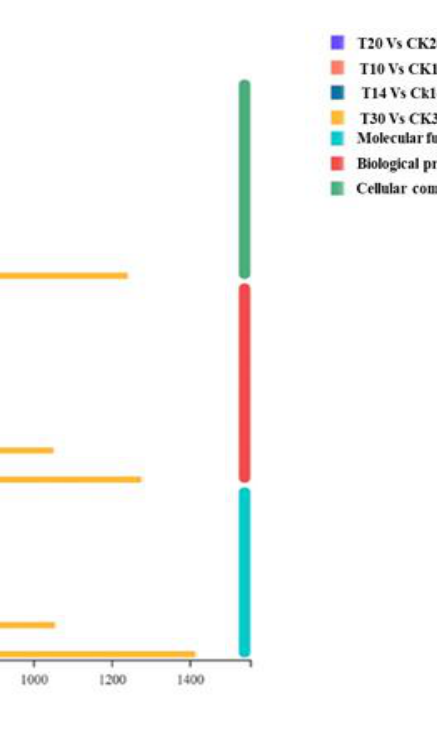
Figure 6. Clusters of KEGG function classification of DEGs based on significantly enriched KEG terms are indicated by dot for corrected p value of <0.05. The dot size represents the number of genes enriched in the reference pathway. There were a total of 108, 115, 99, and 104 DEGs for 715, 697, 366, and 1535 pathways in (T10 vs. CK10, T14 vs. CK14, T20 vs. CK20, and T30 vs. CK30), respectively. Detail given in Supplementary File S2.